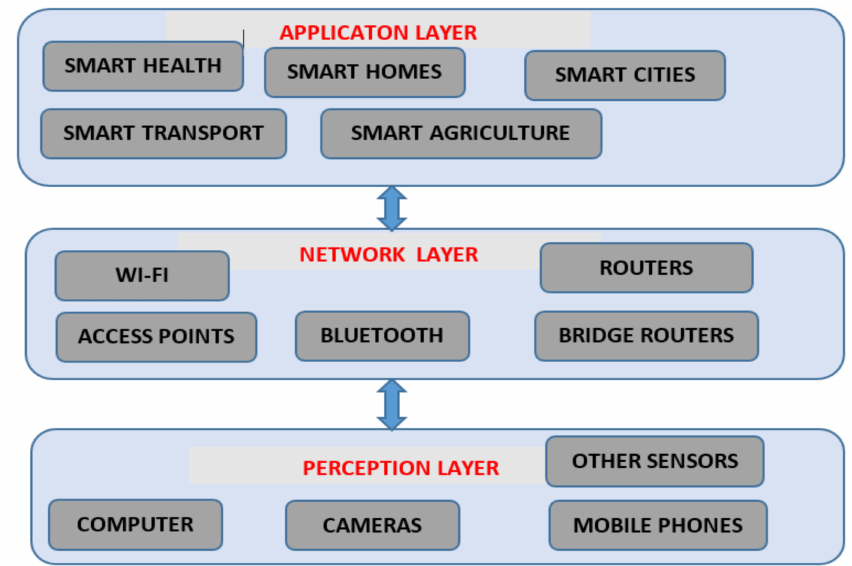
Figure 2. A Three-Layer IoT